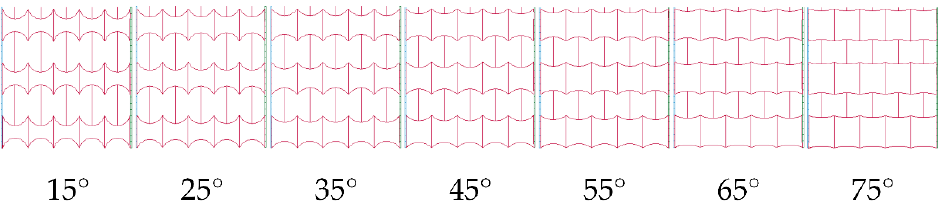
Figure 14. Concave arc honeycomb with different concave angles.